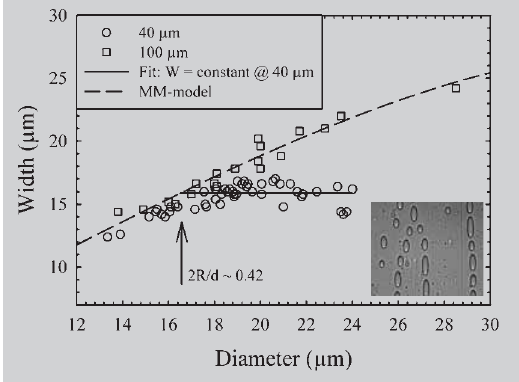
Figure 3 (left): Droplet width as a function of the initial droplet diame- ter at a shear rate of 0.38 s -1 (5% PIB in PDMS) for two gap spacings. Experiments were performed using a Linkam parallel plate shear- ing cell. Figure 4: a) Single droplet relaxation after steady shearing at 0.75 s -1 (5 wt% PIB in PDMS at a gap spacing of 40 μm) and b) data from a) corrected for droplet deformation. Experi- ments were performed using a Linkam parallel plate shearing